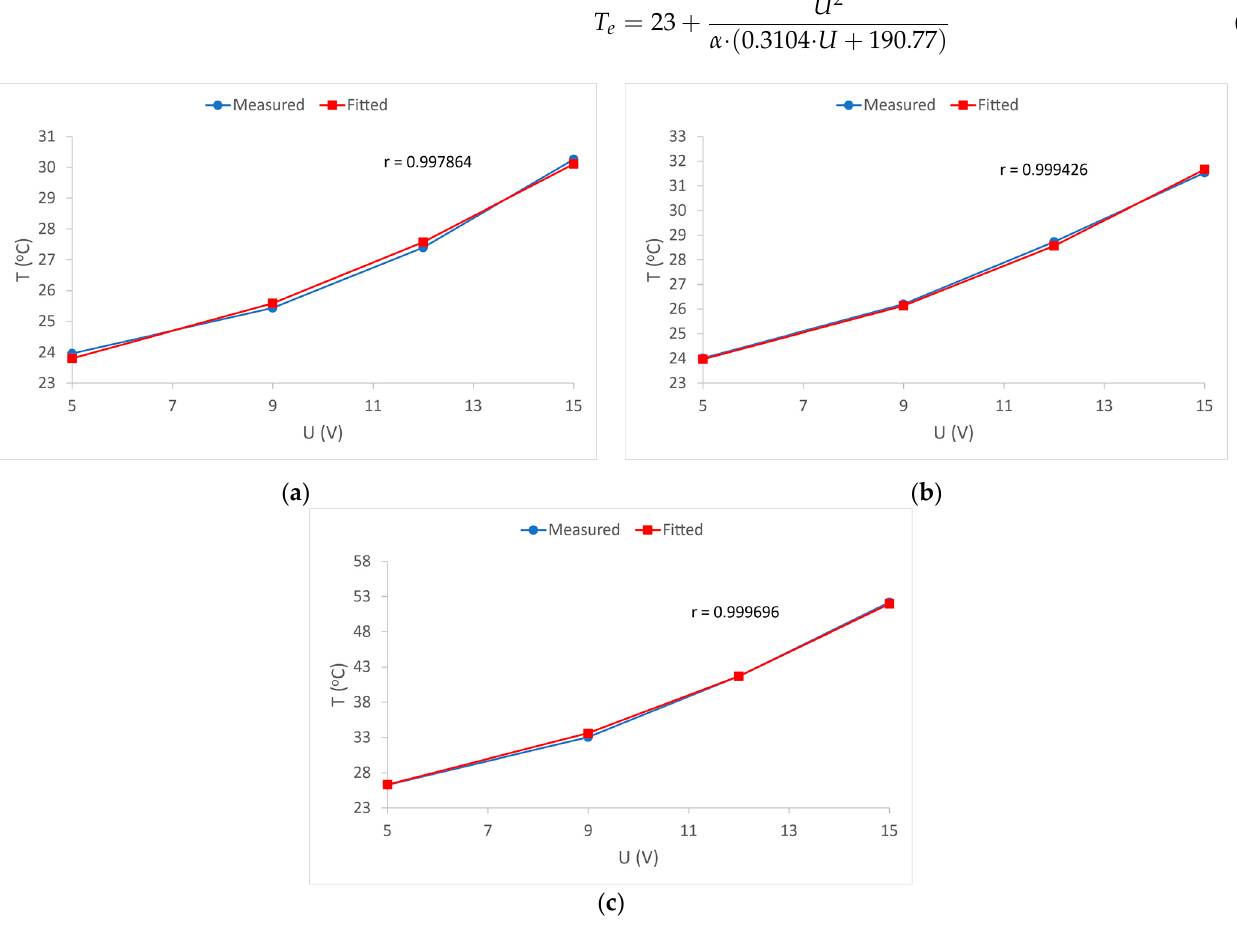
Figure 13. Dependence of equilibrium temperature T e of electrically conductive yarns on supply voltage U : ( a ) sample 1; ( b ) sample 2; ( c ) sample 3.